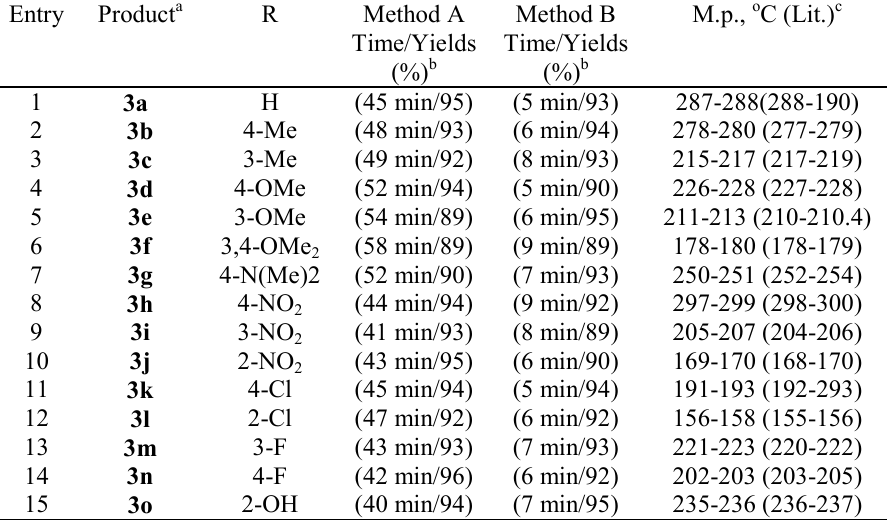
Table 2 . DBH catalyzed synthesis of